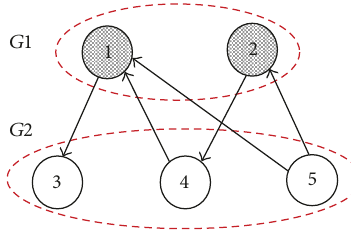
Figure 7: The directed bipartite topology of the heterogeneous MASs.